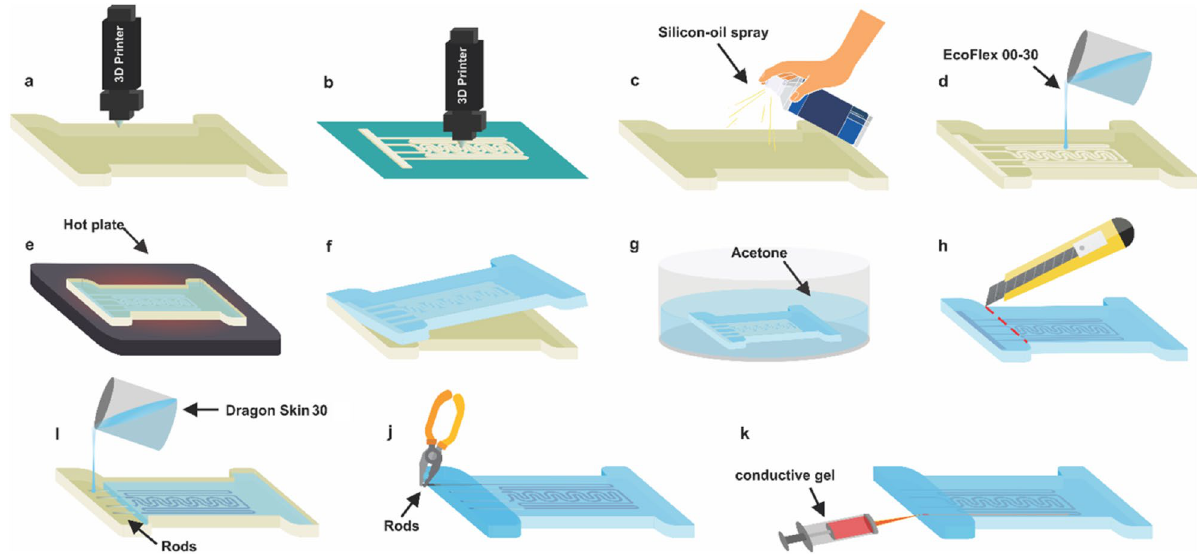
Figure 3. Fabrication process ( a ) 3D printing of the mold with ABS. ( b ) 3D printing the scaffold with ABS. ( c ) Spraying silicon oil on the mold, ( d ) pouring the Ecoflex 00-30 into the mold. ( e ) Curing Ecoflex 00-30: heated to 120° for 20 min. (f) peeling off the chip from the mold. ( g ) Dipping the chip into the acetone. ( h ) Cropping the clamp region. ( i ) Filling clamp region with Dragon Skin 30 (room-temperature-vulcanizing) silicone rubber. ( j ) Extracting the rods from the chip. ( k ) Filling the channel with conductive gel (a combination of water and propylene glycol).